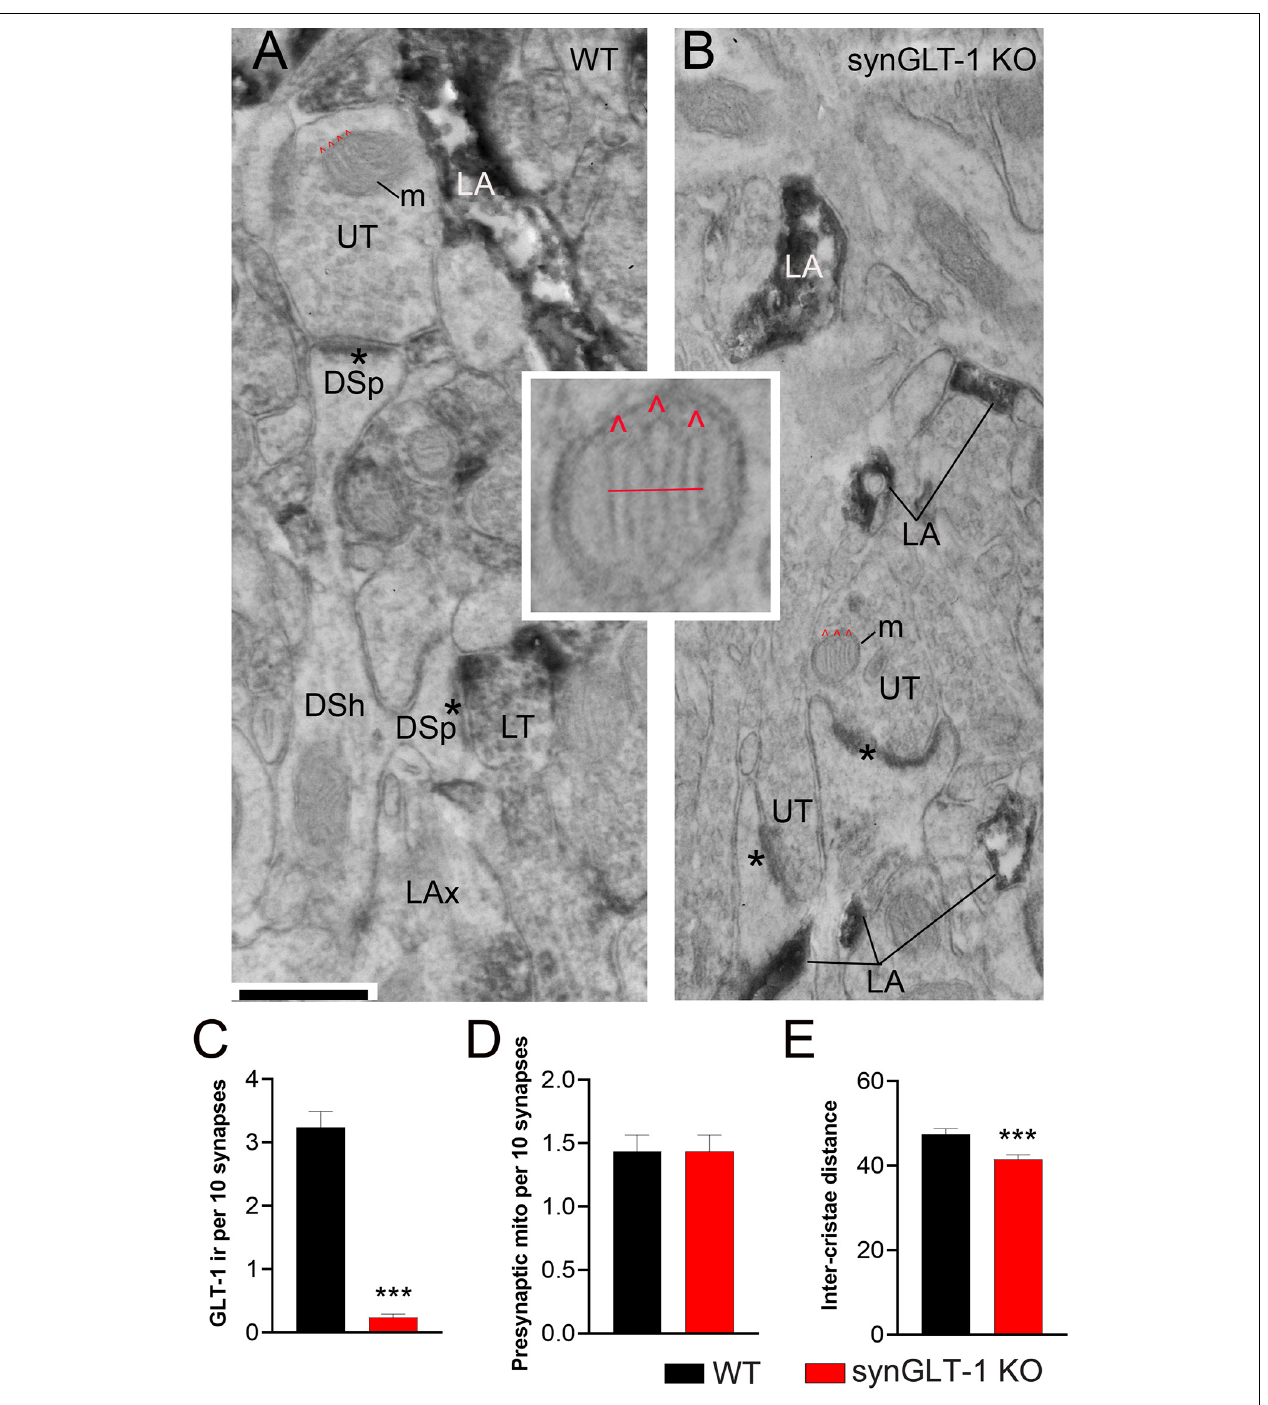
FIGURE 7 | Neuronal GLT-1 knockout decreased inter-cristae distance of presynaptic mitochondria. Panels (A,B) show examples of electron micrographs taken from the WT (A) vs. synGLT-1 KO (B) hippocampus at 22–24 weeks of age. Within the synaptic neuropil of WT animals, only a fraction of axon terminals forming asymmetric synapses with thick PSDs (asterisks; presumably excitatory) upon dendritic spines (DSp) are GLT-1 immunolabeled (LT, abbreviation for “labeled terminal”). Immunolabeling within the axon terminal is evident, based on the diffuse distribution of electron-dense material reflecting the HRP-DAB reaction product. Immunolabeling extends beyond the terminal portion of axons (LAx, abbreviation for “labeled axons”). Axon terminals lacking immunolabeling are labeled as UT (unlabeled terminals). As expected, LT is scarce within KO tissue but both synGLT-1 KO and WT tissue exhibit intense GLT-1 immunolabeling of astrocytic processes (LA, abbreviation for “labeled astrocyte”). DSh = dendritic shaft. Each panel shows examples of mitochondria (m) within axon terminals, with cristae indicated